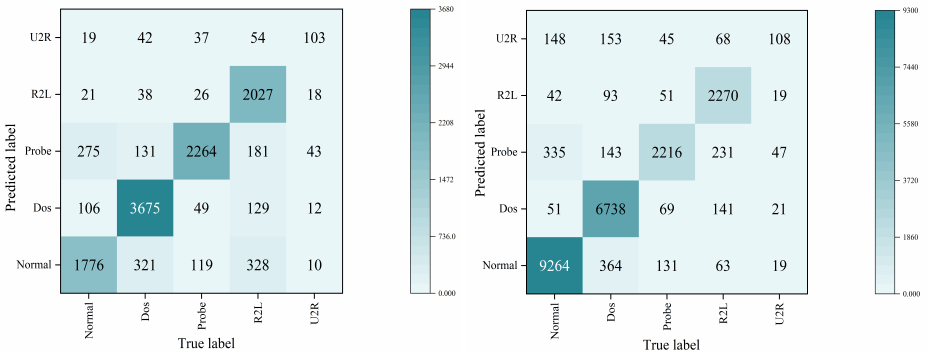
Figure 5. IDD confusion matrix (KDDTest+ and